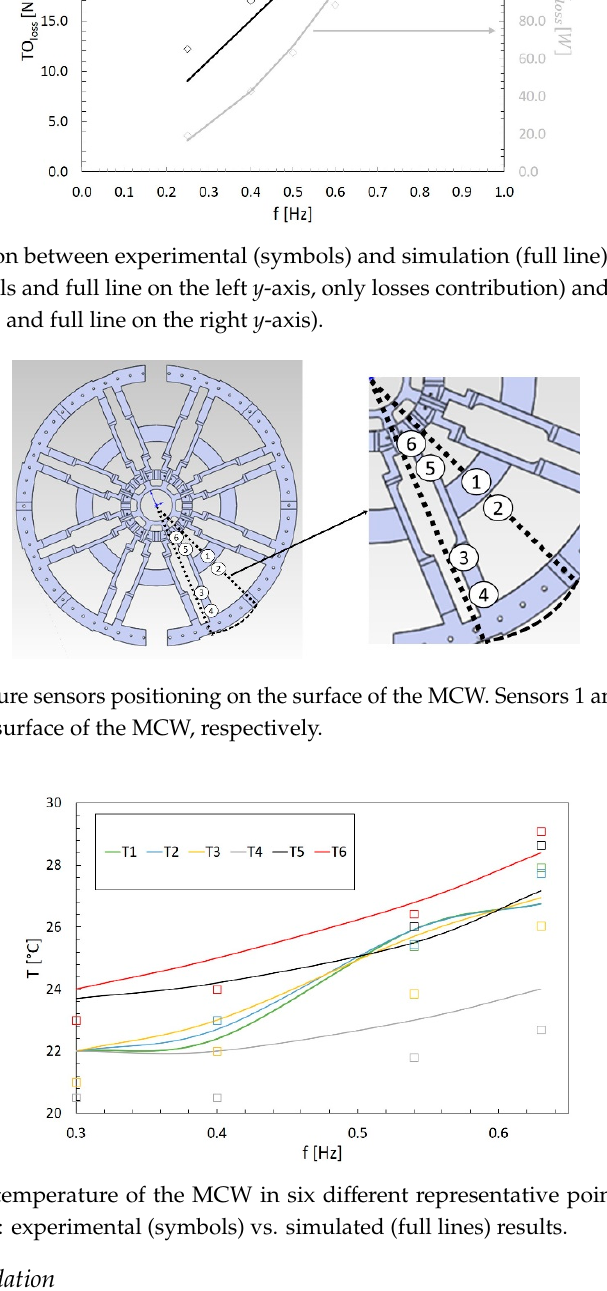
Figure 9. Comparison between experimental (symbols) and simulation (full line) results of resistant torque (black symbols and full line on the left y -axis, only losses contribution) and mechanical power losses (grey symbols and full line on the right y -axis).